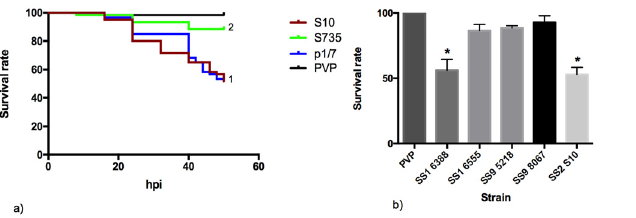
Fig 4. Zebrafish larval mortality correlates with virulence of the injected S . suis strain in pigs. a. Survival curve of yolk-injected larvae with three different S . suis serotype 2 strains. Larval viability was checked every 8h for the first 40h, then every 2h. (1) p < 0.001 compared with S735 and PVP control curves. (2) p < 0.01 compared with S10, P1/7 and PVP control group. b. Survival rate of yolk-injected larvae with different S . suis strains; larval survival was determined at 48 hpi. * p < 0.001 compared with SS1 6555, SS9 5218, SS9 8067 and PVP control group. Results were obtained in 3 independent experiments, and 25 larvae were injected per group.